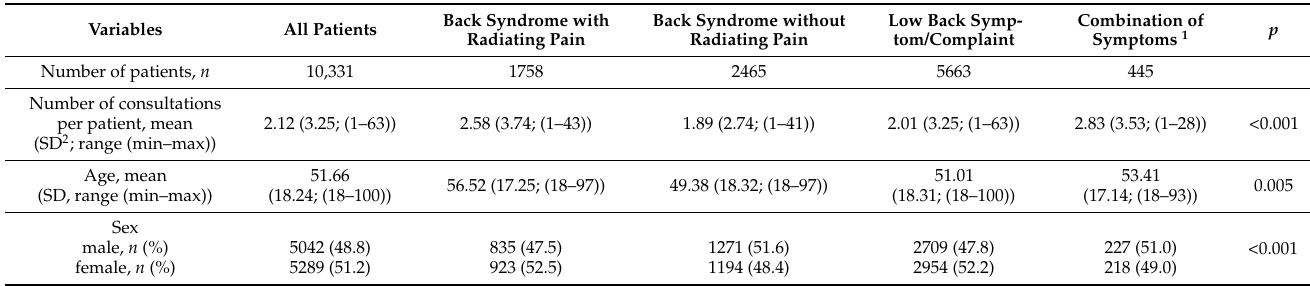
Table 1. Basic characteristics of 10,331 patients with the diagnosis of low back